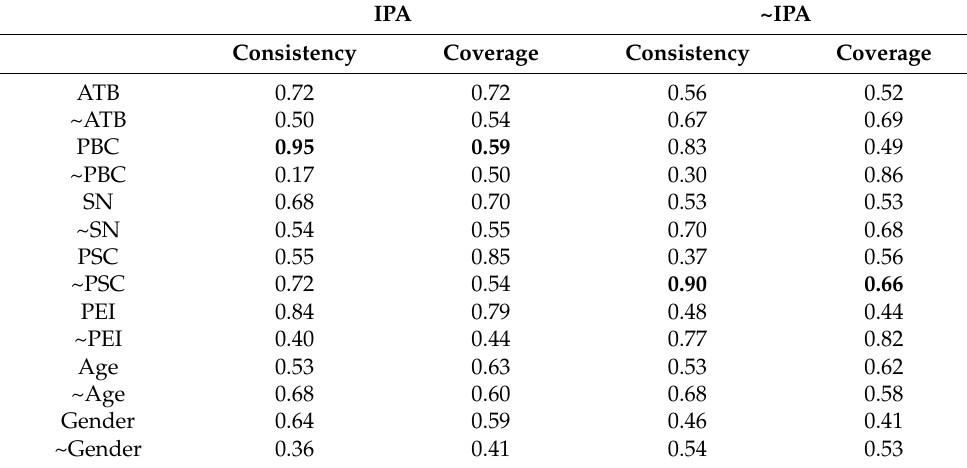
Table 4. Necessary conditions for high and low levels of